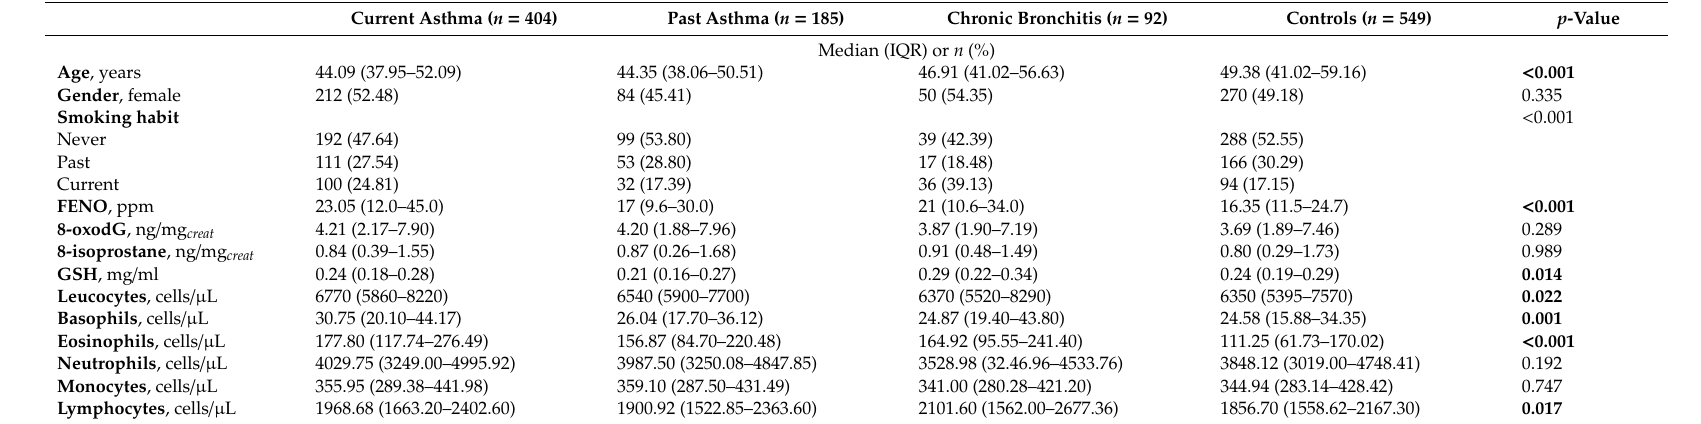
Table 1. Characteristics of the sample, statistics for hierarchical classification of